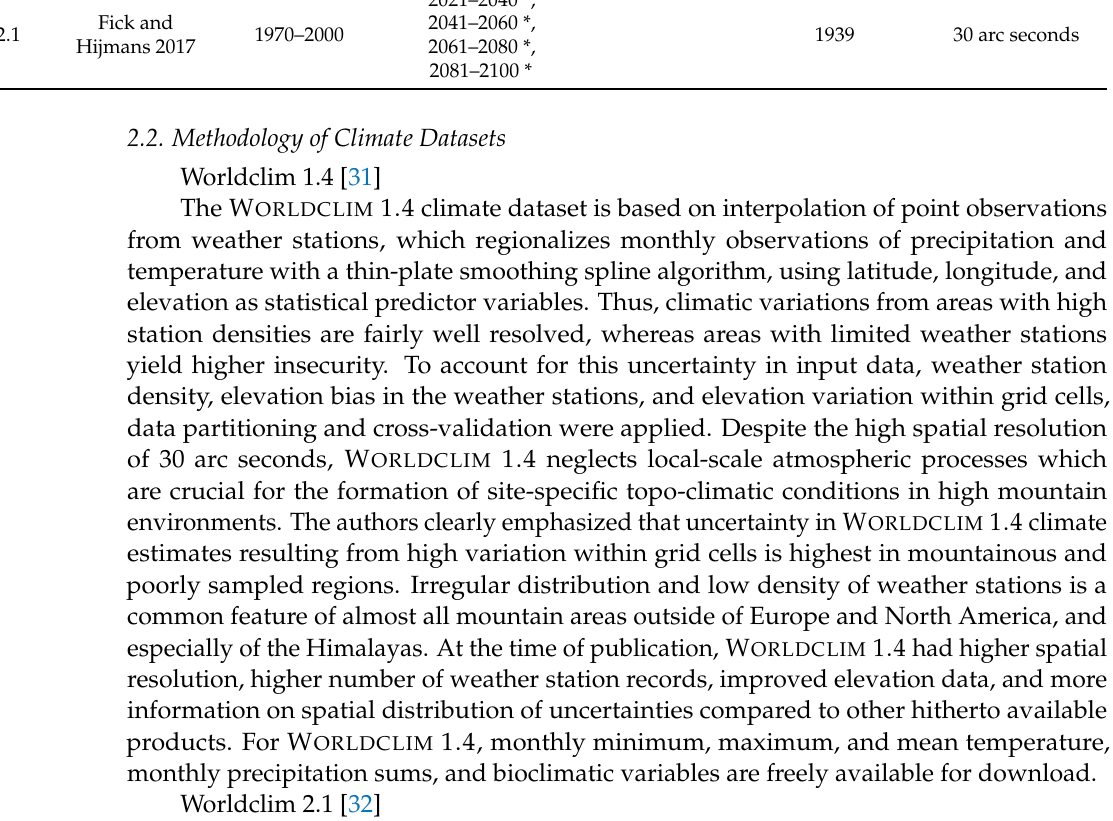
(Table 1). Future climate data (2021–2100), with four different Representative Concentra- tion Pathways (RCPs), ranging from low to high (2.6, 4.5, 6.0, 8.5) for numerous Global Circulation Models (GCM), are available for C HELSA 1.2 and W ORLDCLIM 1.4 at 30 arc seconds, whereas for W ORLDCLIM 2.1, it is only available at 2.5 arc minutes. Although C HELSA 1.1 from 2016 and W ORLDCLIM 1.4 from 2005 are replaced by updated versions and their authors recommend using the most recent datasets, they are still included in this comparison as they were and to date still are widely used in ecological studies.